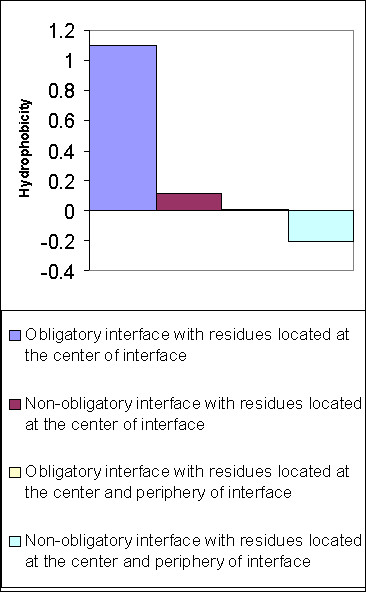
Hydropathy plot for the interface patch. The figure shows hydropathy plot for both obligatory and non-obligatory interfaces and for the residues in the core of the interface and in entire interface.